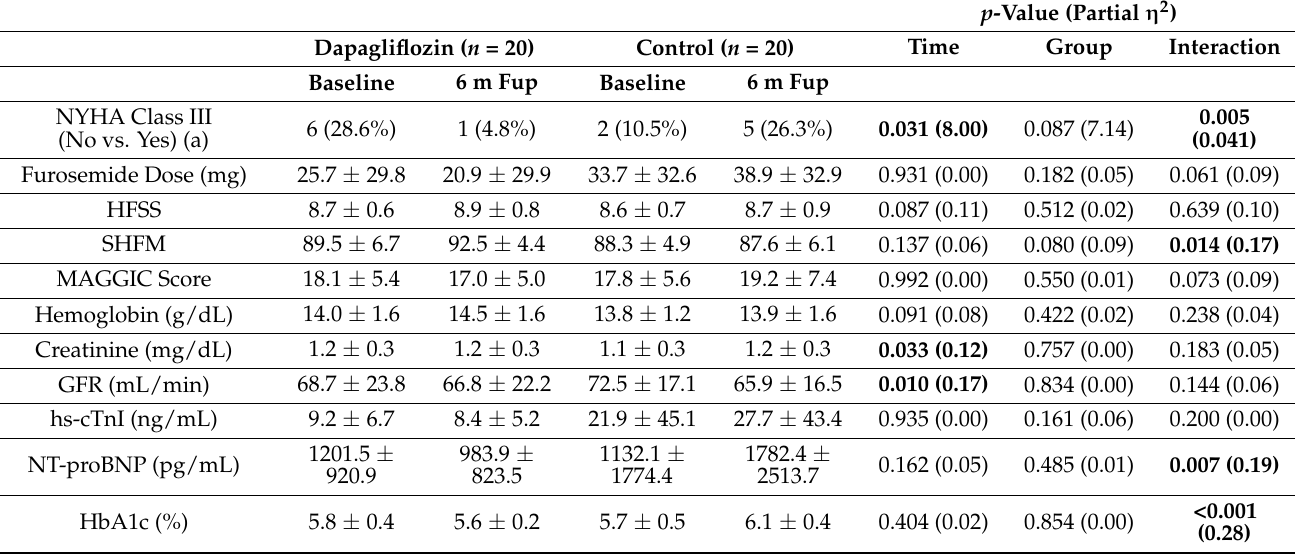
Figure 3. Comparison of CPET parameters variation between baseline and 6 month follow-up. Table 3. Comparison of clinical, echocardiographic and exercise parameters variation between